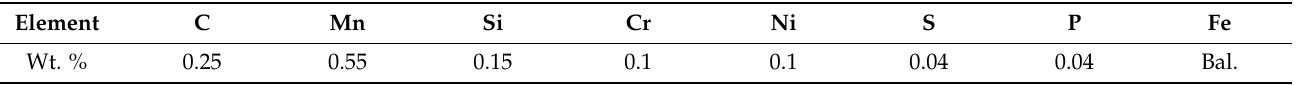
Table 1. Chemical composition of the rolled rebar steel (Rolled Egyptian Steel Grade B400B-R). Element